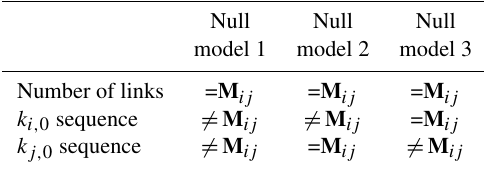
Table 2. How different null models were